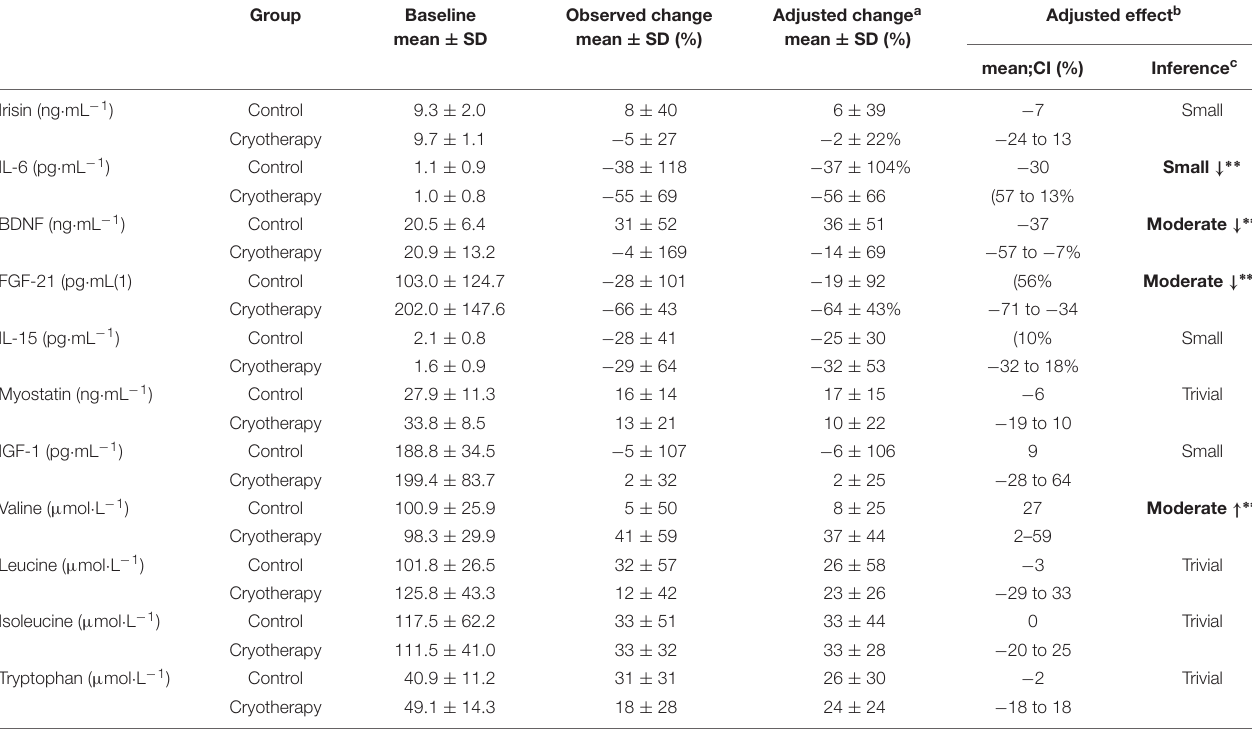
TABLE 4 | The effect of first exposure to whole body cryostimulation or passive rest on immunological response and amino acid profile among all volleyball